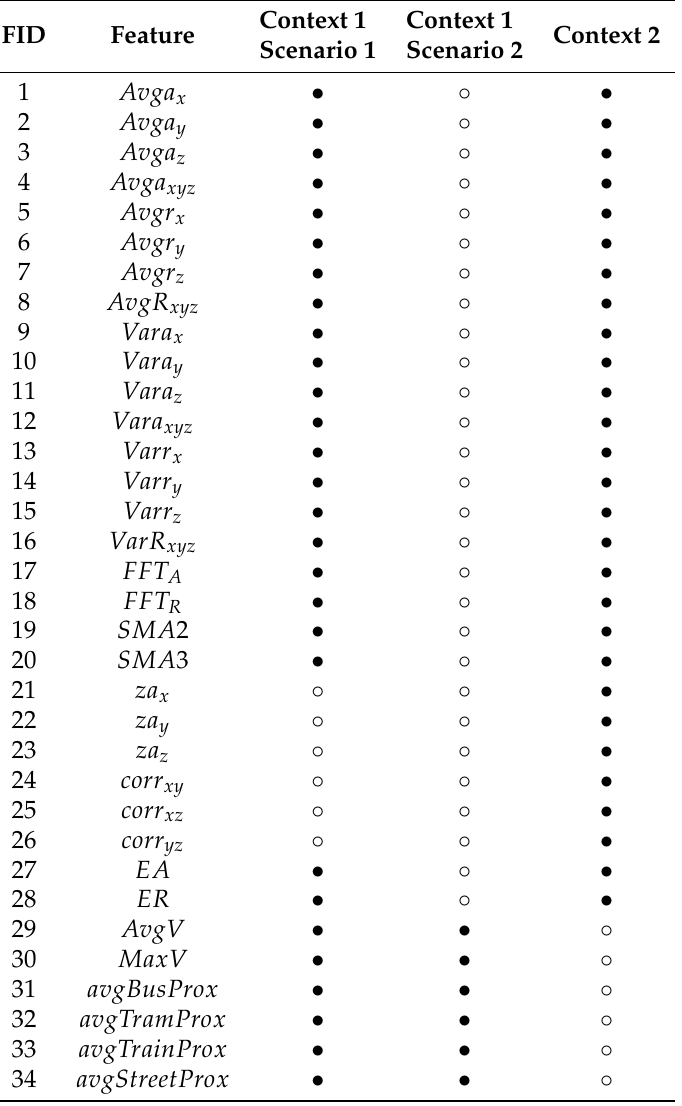
Table 1. Feature selection in different contexts. A • denotes the corresponding feature is selected under the given context. Likewise ◦ denotes the feature is not